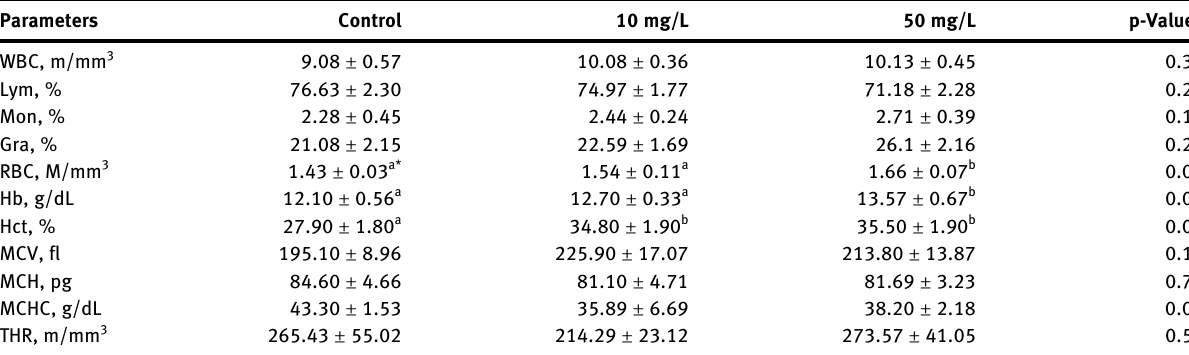
Table  : The hematology parameters of carp ( Cyprinus carpio) after exposed to acrylamide for  h). (mean ± S.E.M.; n=  ). Parameters